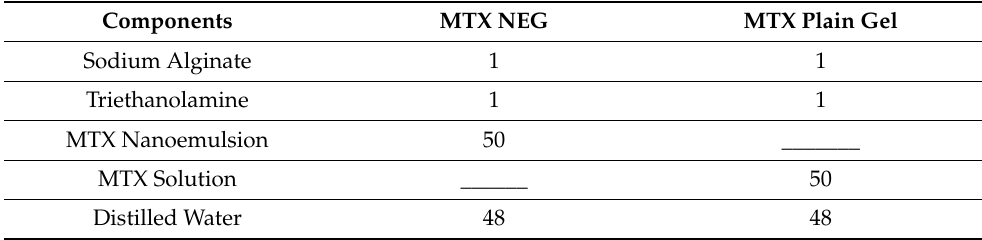
Table 1. Composition of MTX NEG and MTX plain gel ( w / w ,